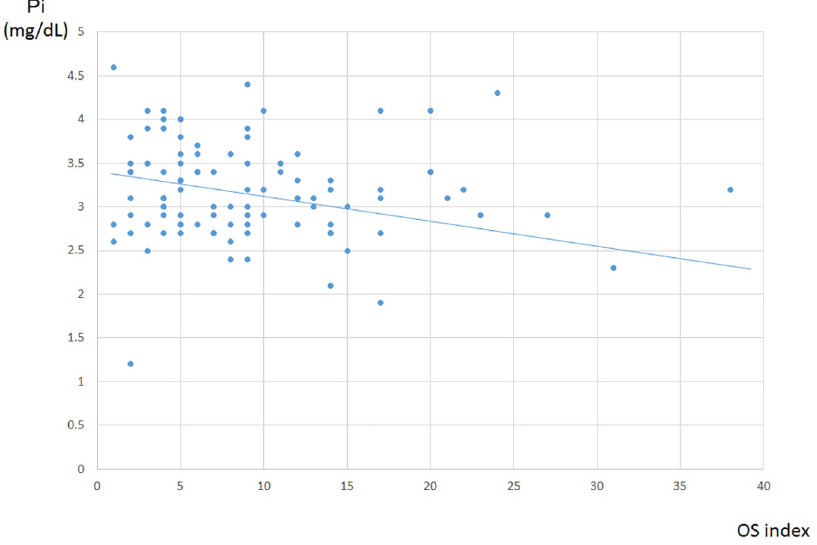
Fig 2. The relationship between the serum concentration of Pi and the OS index in the OPLL group. A negativecorrelationwas found. (p < 0.001,r = -0.51).